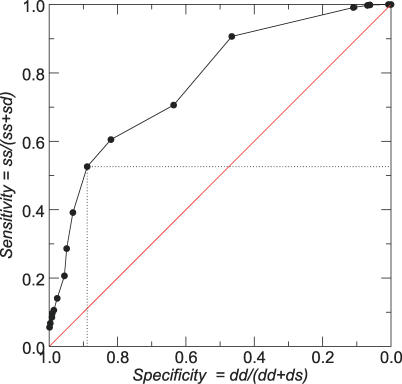
ROC Curve of the Global Comparison of Clustering and RFAM FamiliesAt a false positive rate of 12%, we achieve a sensitivity of 52% (correctly grouping together sequences of the same family), which is more than sufficient to detect families.